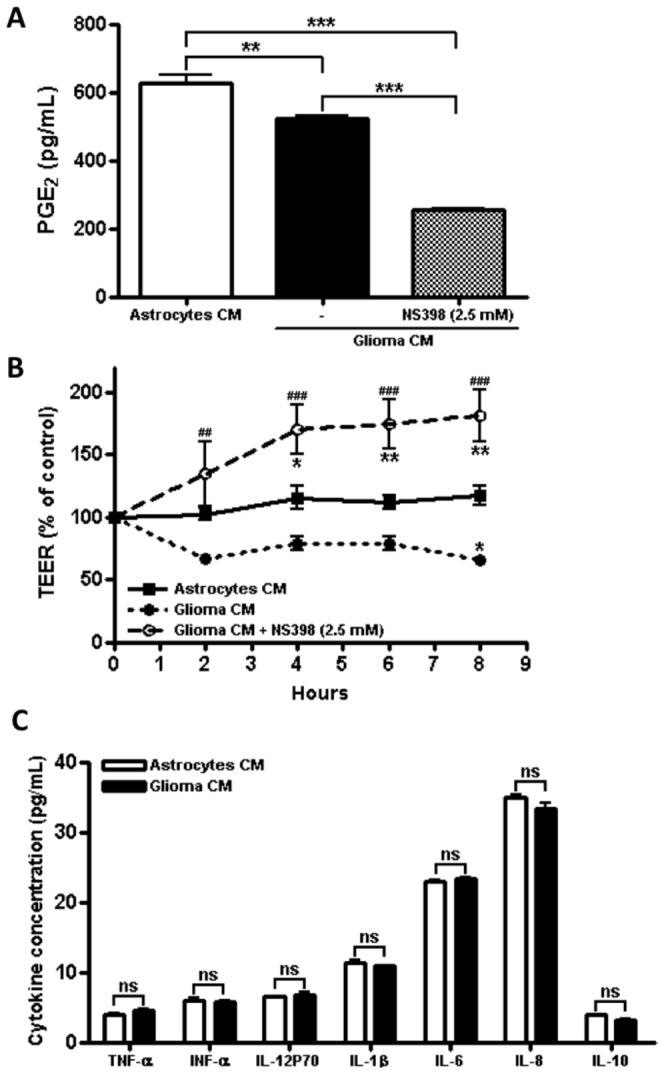
The presence of PGE2 and the lack of EGF in glioma C6 CM promote a leakier
BBB.A) Quantitation of PGE2 by ELISA in astrocyte CM and in glioma C6 CM derived from
cells treated or not with COX-2 inhibitor NS398. N = 3, F(2,6) = 161.9; **P<0.01, ***P<0.001;
as assessed by one-way ANOVA followed by Bonferroni's post hoc test. B) TEER of RBMECs cultures
incubated in the basal compartment with astrocytes or glioma C6 CM derived from control or NS398
treated cells. N = 3, F(2,20) = 53.56; *P<0.05, **P<0.01 with respect to astrocytes CM;
##P<0.01, ###P<0.001 with respect to glioma C6 CM; as assessed by
two-way ANOVA followed by Bonferroni's post hoc test. C) Quantitative analysis of cytokines IFN-α,
TNF-α, IL-12p70, IL-1β, IL-6, IL-8 and IL-10 present in astrocyte and glioma C6 CM. N = 3, df = 2,
as assessed by Student's t-test.